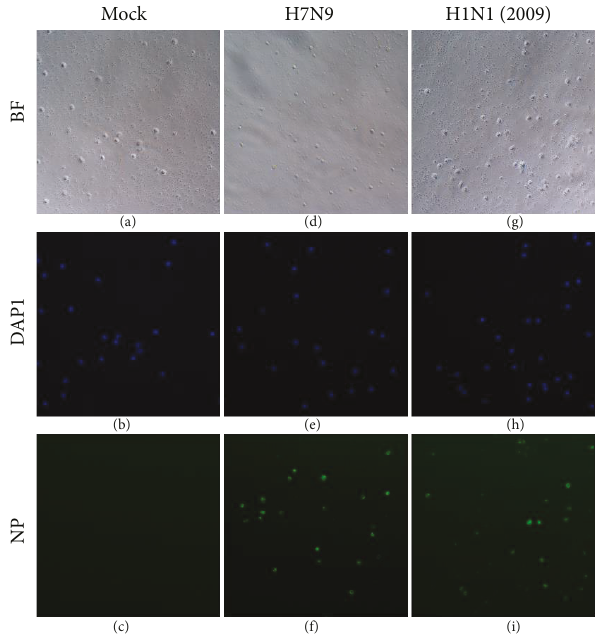
Figure 2: H7N9 virus is able to directly infect human PBMCs in vitro . Typical images of immuno fl uorescent staining of the viral NP protein expressed in mock- (a – c), H7N9- (d – f), and H1N1(2009) virus- (g – i) infected human PBMCs at 24 h postinfection ( n = 6 ). Green, NP; blue, DAPI counterstaining of cell nuclei. BF: bright fi eld; DAPI: 2-(4-amidinophenyl)-6- indolecarbamidine dihydrochloride; NP: nucleoprotein. 100x was